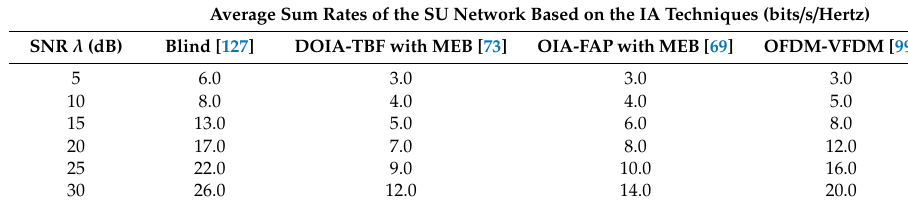
Table 7. Average sum rates against typical SNR values for the second paradigm with space–time water-filling (ST-WF) for the multiple SU MIMO link [69,73,99,127].